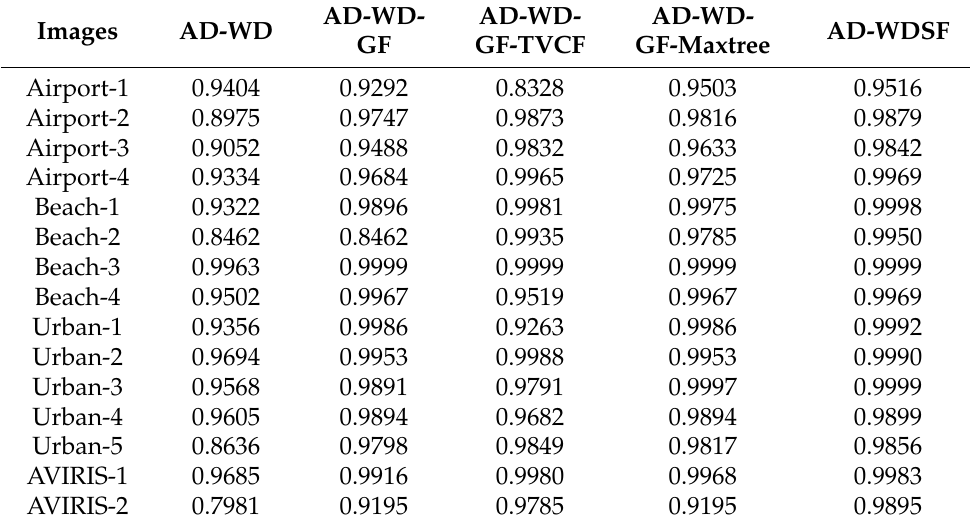
Table 2. AUC Values of the combination methods on ABU and AVIRIS data sets.